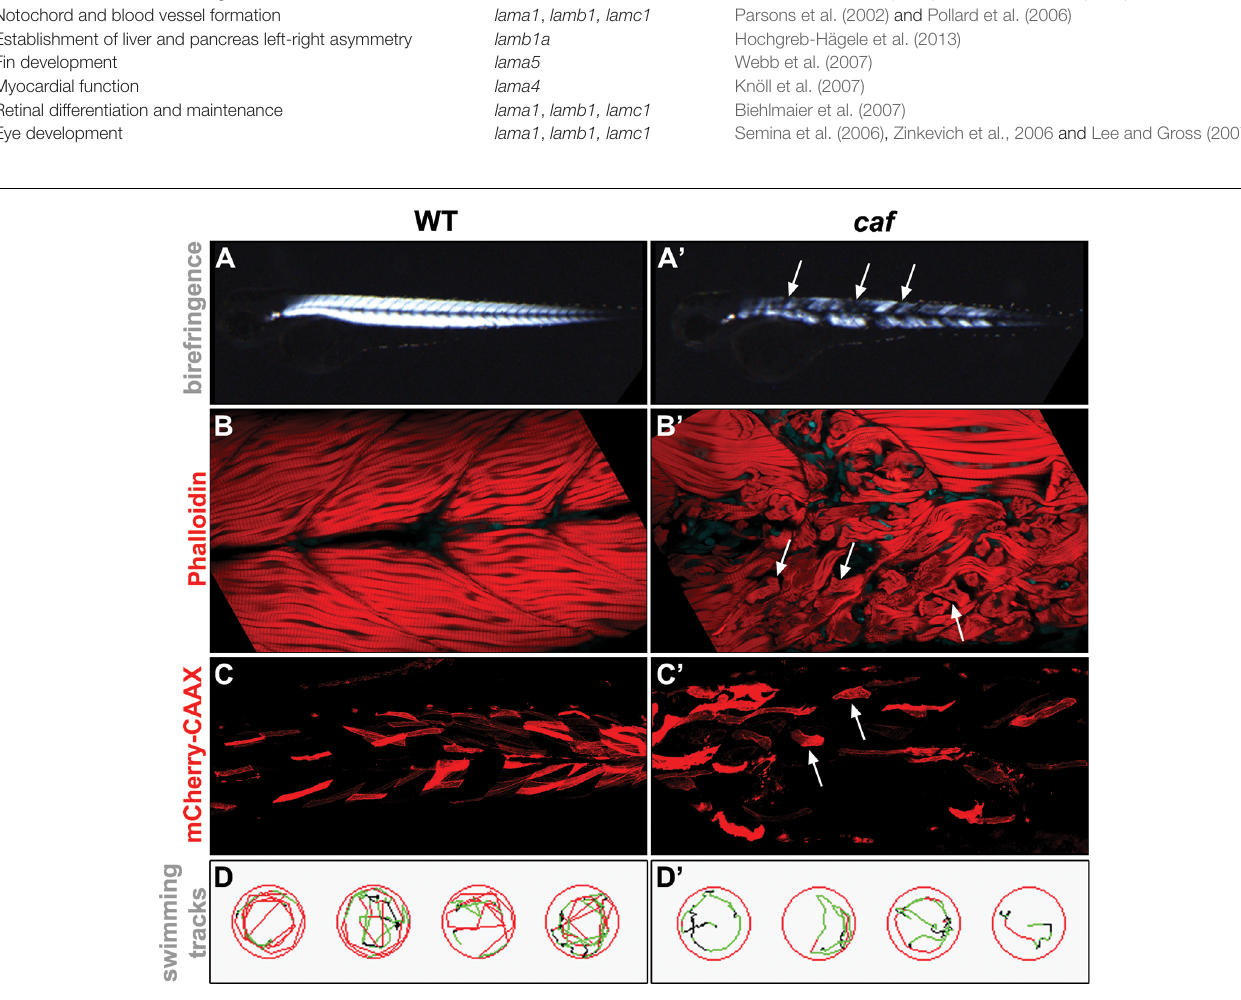
FIGURE 1 | Examples of experimental approaches used for the phenotypical analysis of the zebrafish LAMA2-related congenital muscular dystrophy (CMD, LAMA2-MD) model. (A,A’) Birefringence assay. The organization of muscle fibers can be seen by polarized light. Detached muscle fibers in the caf mutant show up as dark regions in the muscle (arrows). (B,B’) Whole-mount staining. Phalloidin stains the actin filaments in the muscle. Muscle fibers detached from the myotendinous junctions (MTJs) in the caf mutant can be easily identified (arrows). (C,C’) Injected fluorescent marker. unc53 :mCherry-CAAX-pA construct (Zhao et al., 2019), which marks muscle cells, was injected into 1-cell stage embryos and visualized by live imaging at 3 dpf. Detached fibers in the caf mutant can be easily identified (arrows). (D,D’) Swimming assay. Swim behavior can be tracked and quantified using Viewpoint Zebrabox software (Viewpoint Life Sciences Inc.). Time spent moving, distance traveled and speed of movement are useful indicators of muscle function. Fewer tracks and lower speed (indicated by green tracks) are seen in the recorded caf